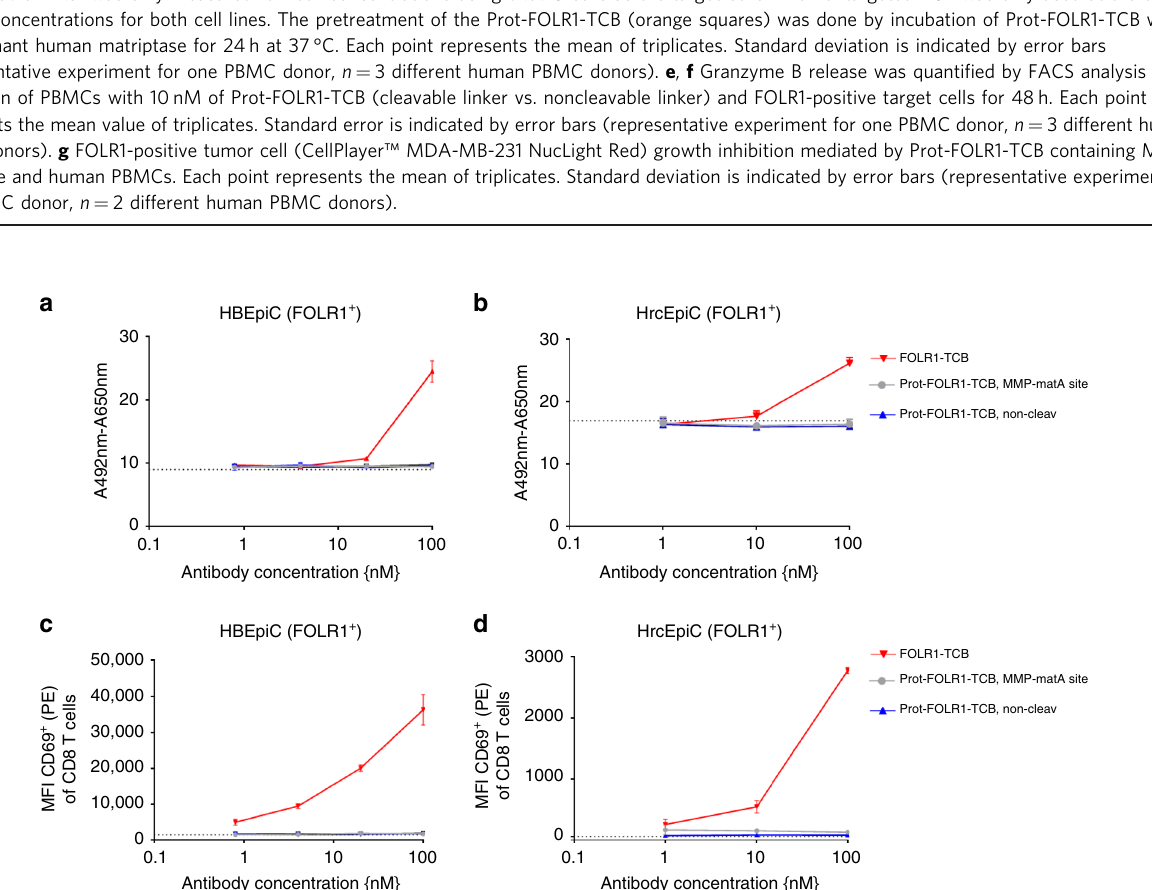
Fig. 6 Cell cytotoxicity of FOLR1-TCB is abolished by blocking of anti-CD3 for primary cells with low FOLR1 expression. T-cell killing of primary cells, expressing low levels of FOLR1, mediated by Prot-FOLR1-TCB with MMP-matA site using PBMCs as effector cells and an E:T ratio of 10:1. a , b Human bronchial epithelial cell (HBEpiC) ( a ) and human renal cortical epithelial cell ( b ) killing assessed after 72 h. Each point represents the mean of triplicates (one human PBMC donor shown, n = 3 different human PBMC donors). Standard deviation is indicated by error bars. c , d Median fl uorescence intensity of CD69 of CD8-positive T cells is shown after incubation with TCB and HBEpiC ( c ) and HrcEpiC ( d ) cells. The dotted line indicates the MFI for CD8-positive T cells incubated without any TCB. Each point represents the mean value of triplicates, standard deviation is indicated by error bars (one human PBMC donor shown, n = 3 different human PBMC